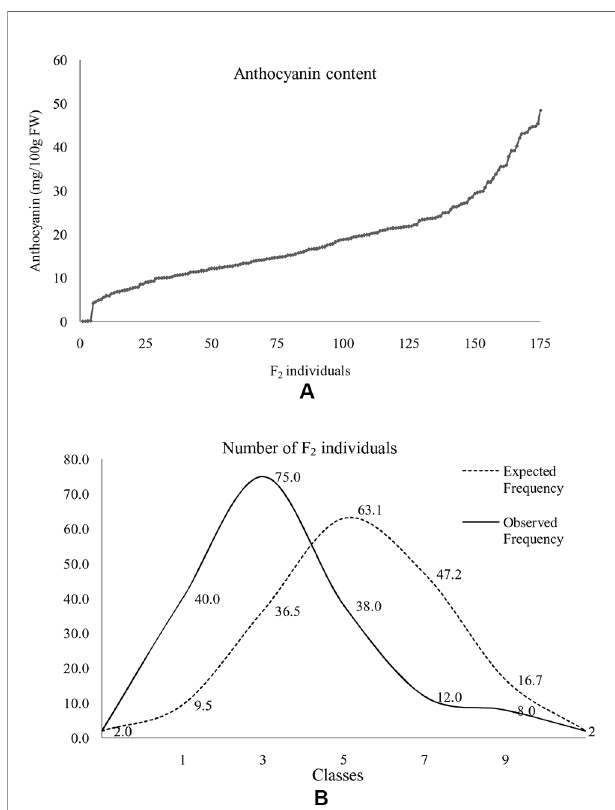
FIGURE 8 | Distribution of anthocyanin content in F 2 population. Anthocyanin in F 2 plants (A) and distribution of F 2 population with reference to normal distribution curve for anthocyanin content based on grouping of 10 mg/100 g FW series (B) . Here, 0 = < 1 mg or not detectable, 1 = 1 – 10 mg,